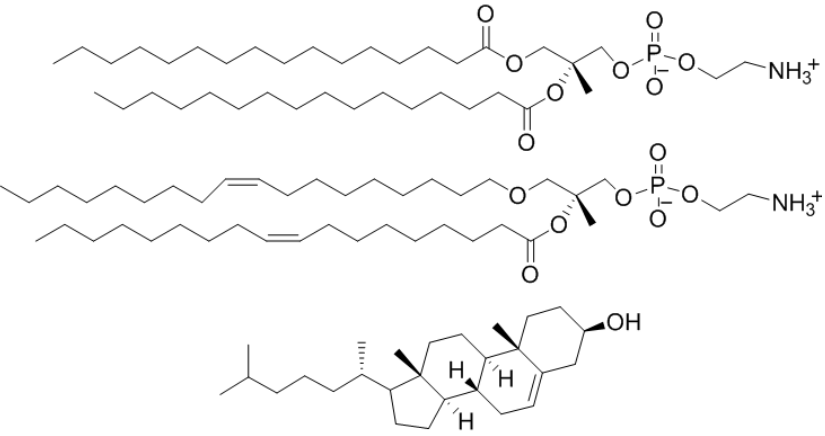
Figure 2. Chemical structures of lipids. DPPC ( top ); DOPC ( center ); and cholesterol ( bottom